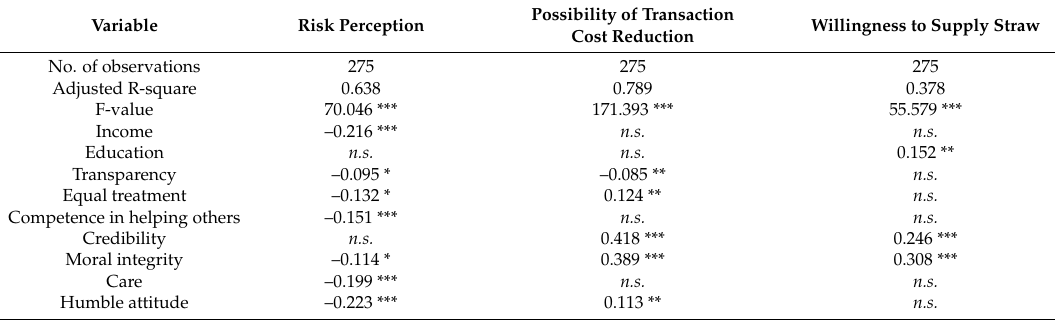
Table 5. Regression of trust factors that influence risk perception, possibility of transaction cost reduction, and willingness to supply